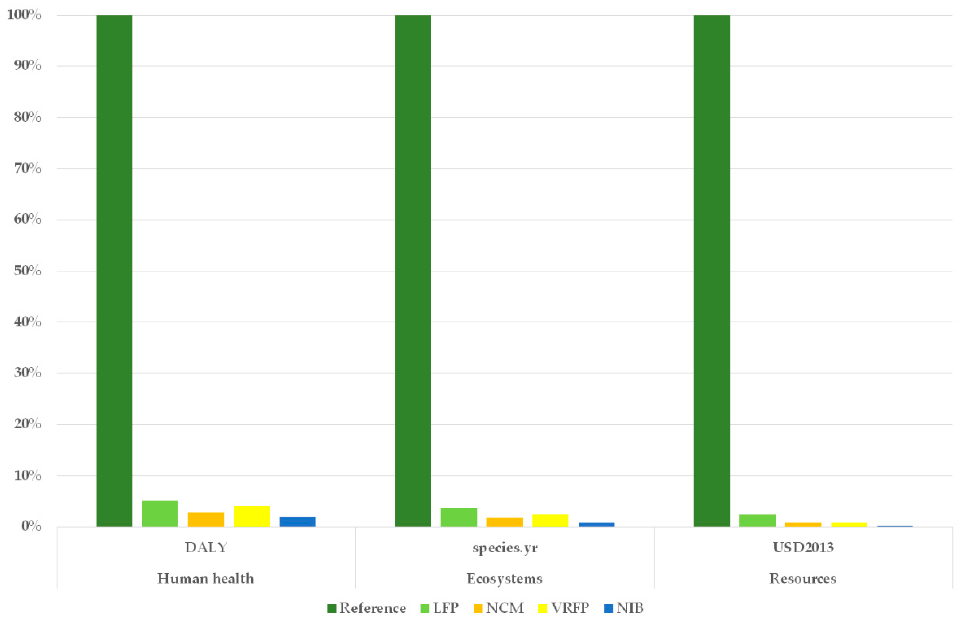
Figure 2. Comparison of the impacts for the different batteries and of the reference case (ReCiPe 2016 method-Endpoint (H)).